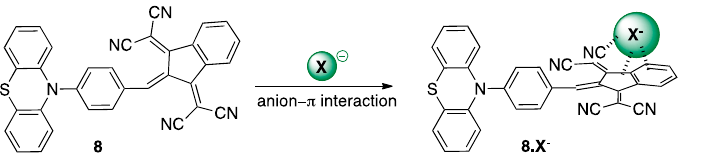
Figure 7. Recognition of X − anions by the chromophore 8 based on anion– π interactions in CH 3 CN affording the adducts 8.X − .